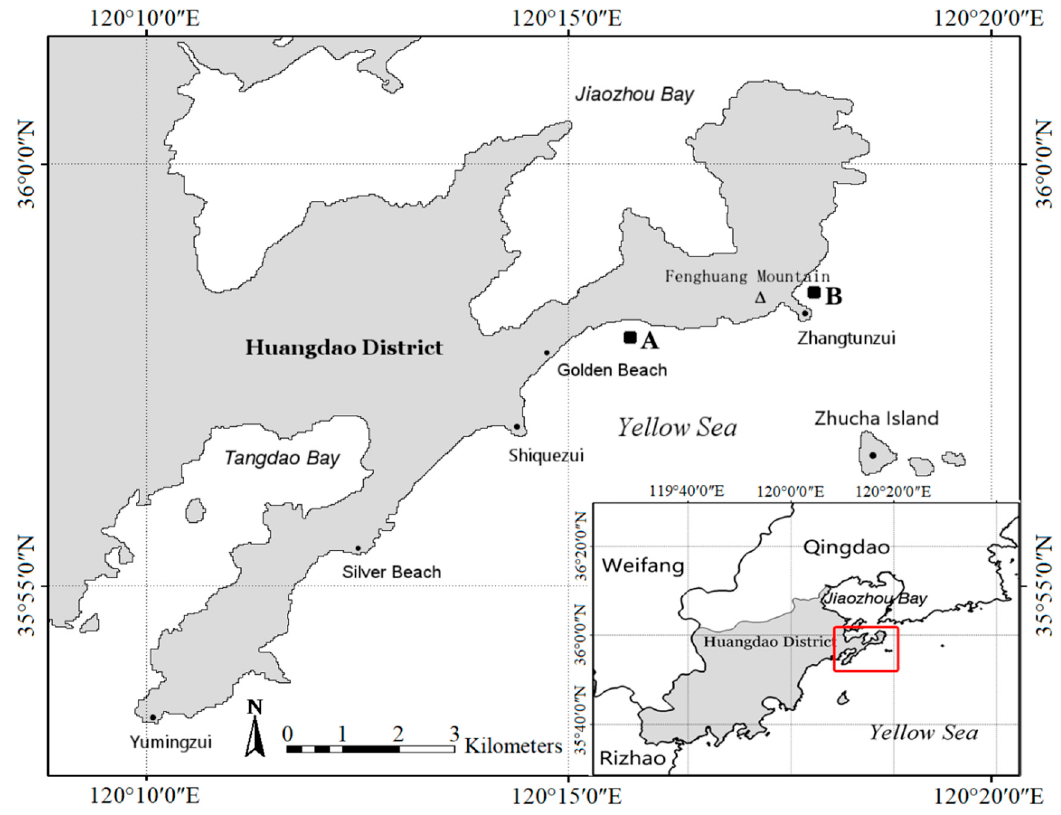
Figure 1. Location of the study areas. Research areas A and B are marked with black solid squares.